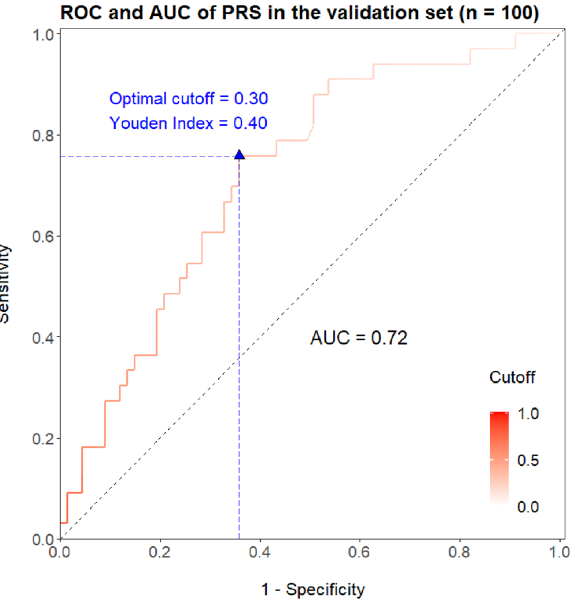
Figure 7. ROC plot of the PRS in the validation set. Cutoff (in the range of [0, 1]) refers to the threshold to dichotomize predicted probability into binary classes. AUC area under the ROC curve. Note: sex and age are included in the predictive